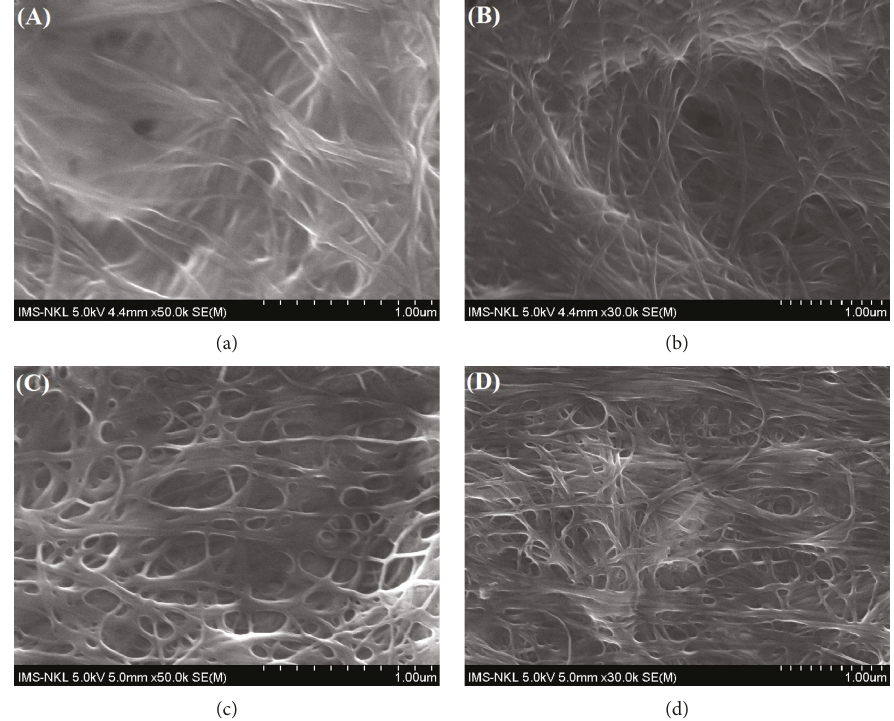
Figure 5: Scanning electron microscopy images of bacterial cellulose treated by sonication at various temperatures: 55 ° C (a), 6 ° (b), 65 ° C (d), and 70 ° C (c).